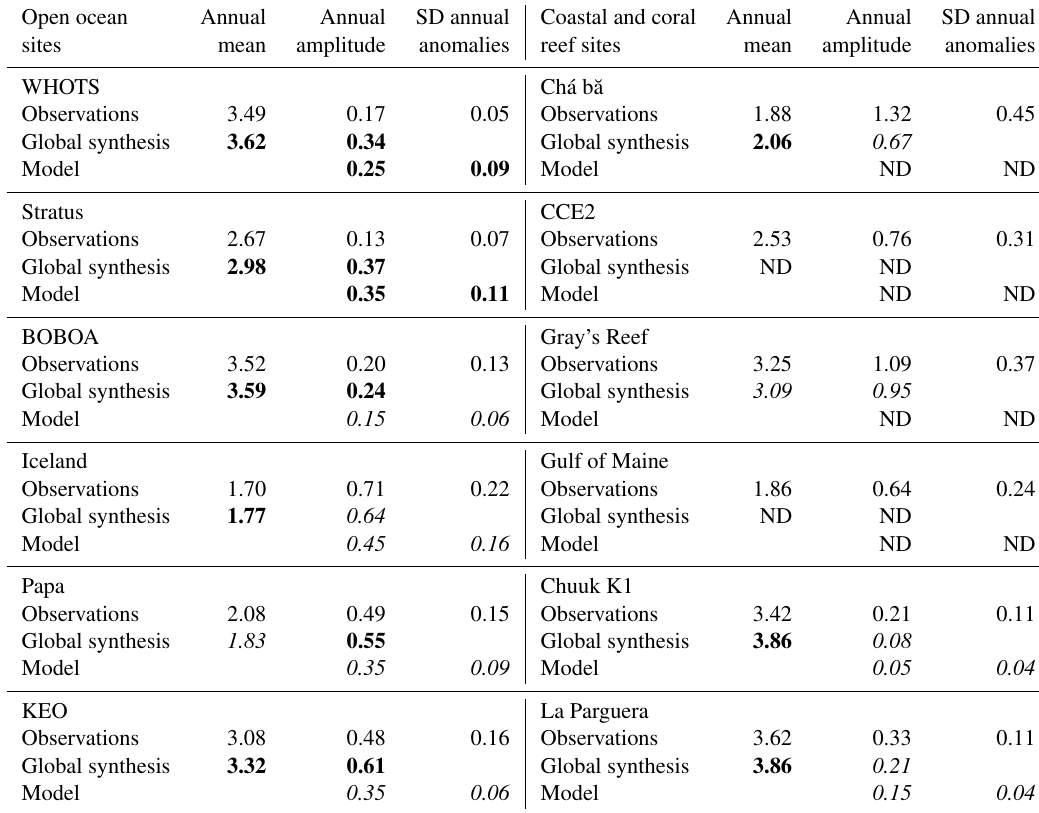
Table 4. Descriptive statistics of (cid:127) arag : annual mean, annual amplitude, and 1SD of annual anomalies from the CO 2 and pH mooring observations, from a global data synthesis of ship-based observations (Takahashi et al., 2014), and a biogeochemical model (Friedrich et al., 2012). Bold values represent values larger than observed values; italicized values represent values lower than observed values. ND signifies no